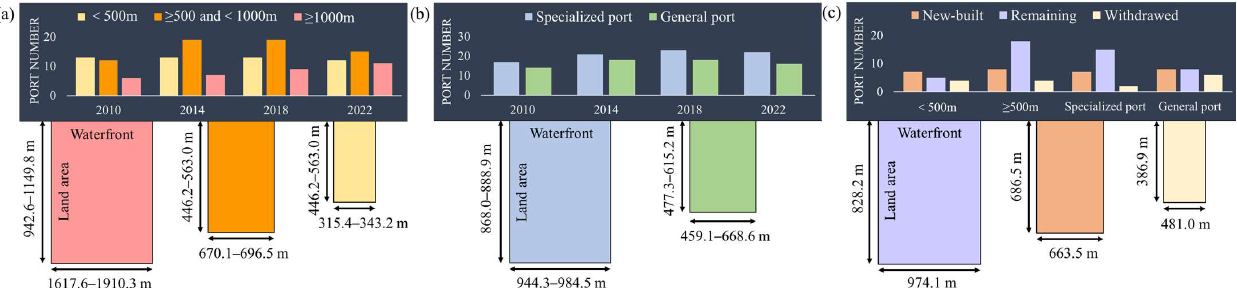
Figure 4. Difference in waterfront length and land area width in different ports. ( a ) number of ports with different waterfront length level and average waterfront length and land area width, ( b ) number of ports with different port function type and average waterfront length and land area width, ( c ) number of ports with different port operation states and average waterfront length and land area width.